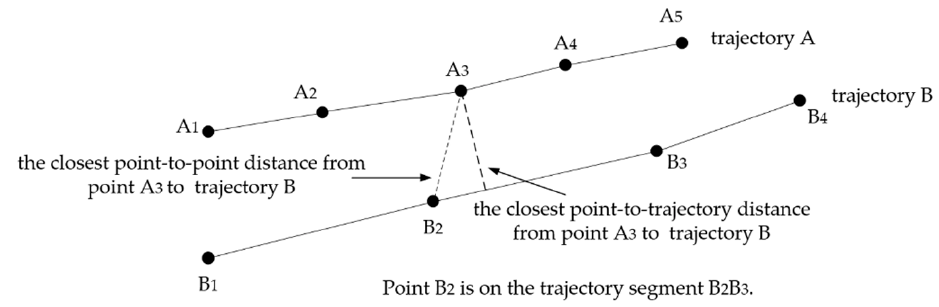
Figure 5. Illustration of Lemma 1.